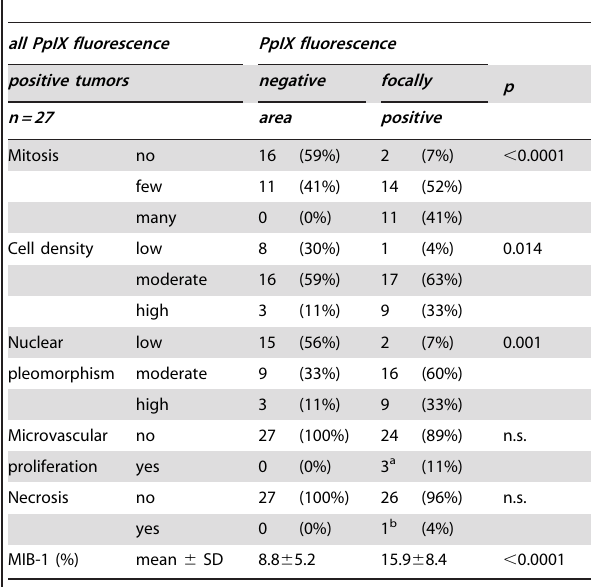
Table 4. All PpIX fluorescence positive tumors (n=27): Assessment of histopathological WHO criteria and proliferation rate in PpIX focally positive versus negative intratumoral areas within the same